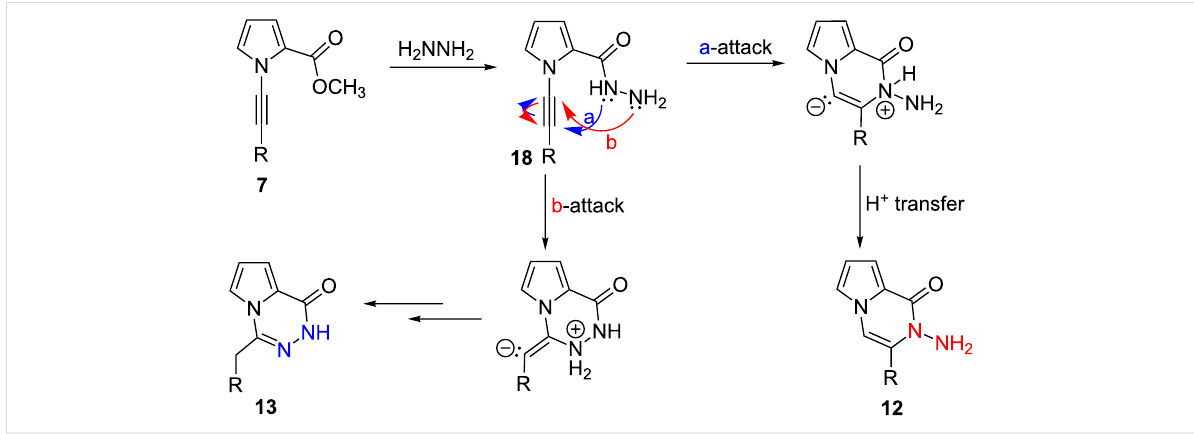
Scheme 4: Proposed reaction mechanism of nucleophilic cyclization reaction of 7 .